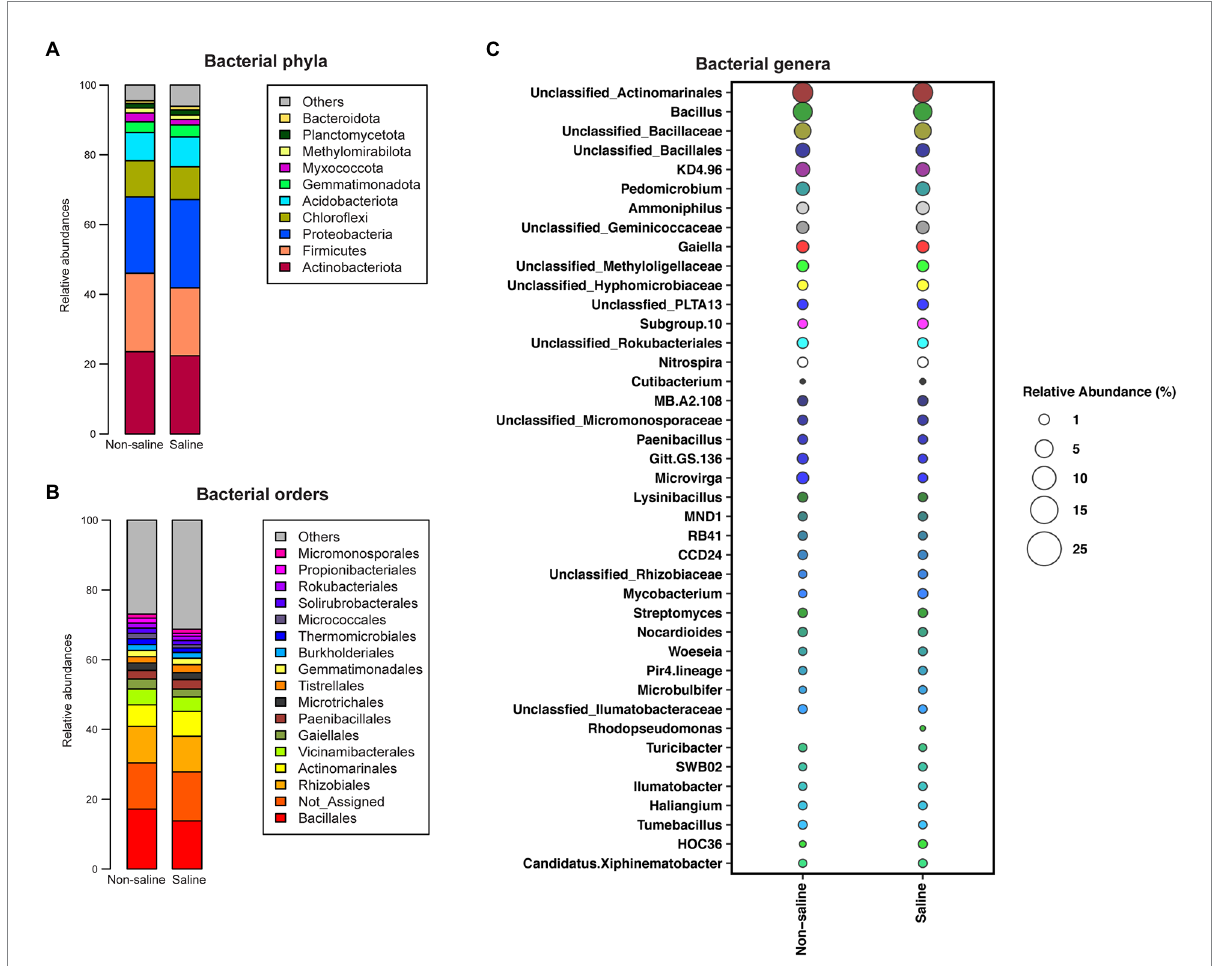
FIGURE 4 The relative abundance of the top bacterial taxa in soil. The relative abundance of bacteria in the soil at the (A) phylum, (B) order, and (C) genus